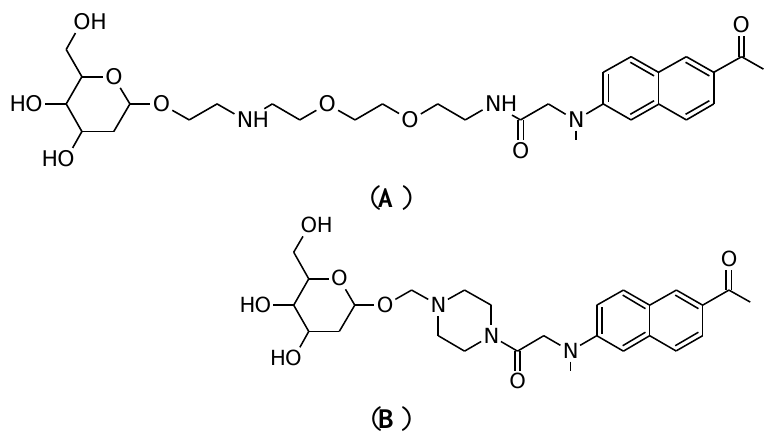
Figure 7. Chemical structures of the two-photon glucose analogues, AG1 ( A ) and AG2 ( B ), developed for two photon microscopy in 2009 by Park at Seoul National